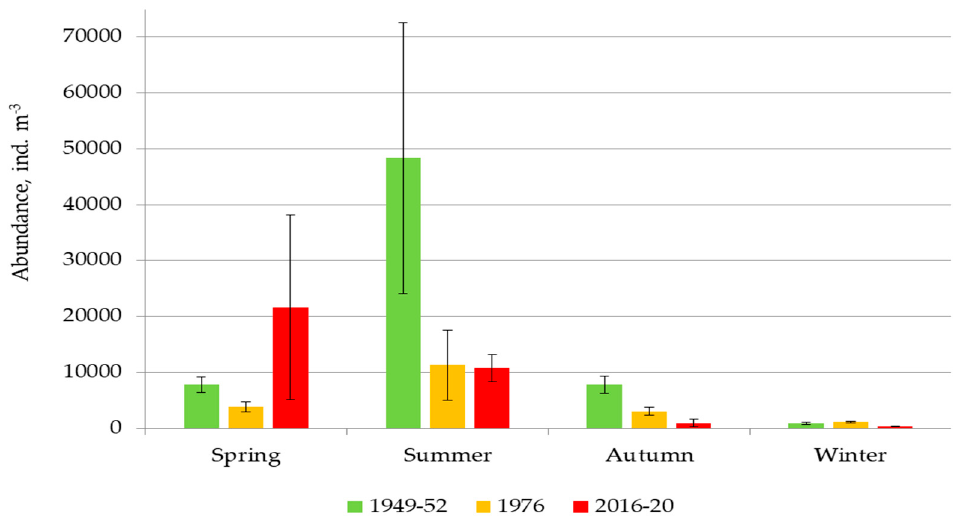
Figure 17. Long-term changes in the average ± SE seasonal abundance of zooplankton (1949–1952 according to [7], 1976 according to [12], 2016–2020 according to [4,5] and project data). Compared with the period of eutrophication, the saprobity calculated by zooplankton indicators on average was 1.83 (Supplementary Materials Figure S8), the value of the index being slightly better compared with the 1970s, when it was 1.88. Both values correspond to β -mesosaprobic zone (moderately polluted waters) [12,37,57]. This also indicates an improvement in the state of the zooplankton community in comparison with the 1970s